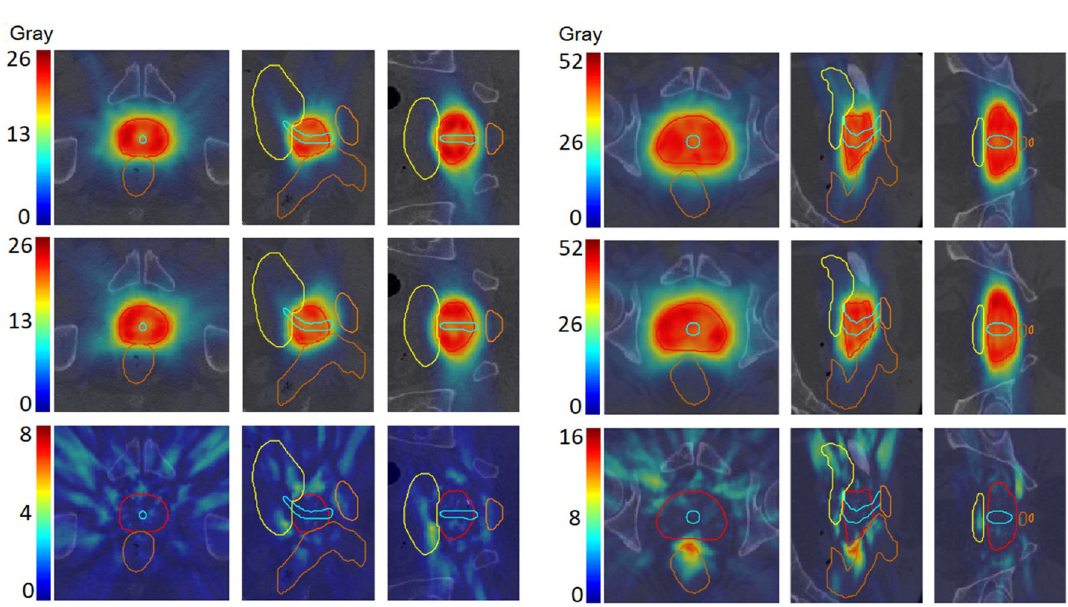
Figure 3. The original real dose (top), DoseGAN synthetic dose (middle), and dose difference (bottom) are shown for patients 7 (left) and 20 (right). The PTV, rectum, bladder, and penile bulb are shown in the red, brown, yellow, and orange contours, respectively. Axial, sagittal and coronal slices are shown from left to